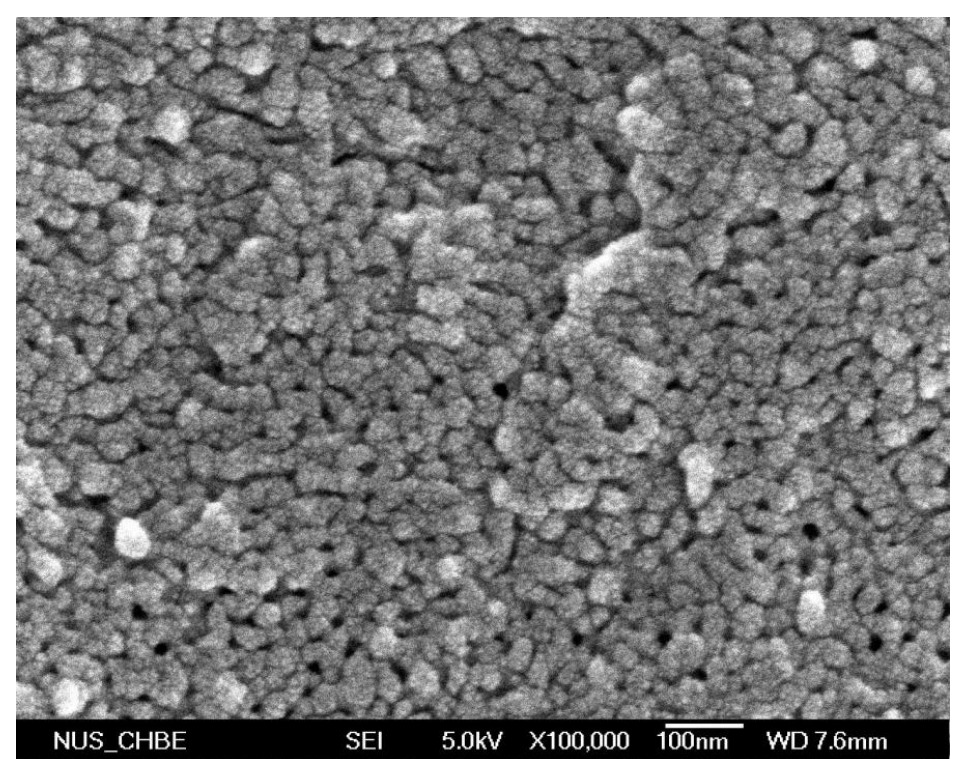
Figure A5. FE-SEM images of cross-linked diblock A150G4S-10 membrane (magnification 50,000×).